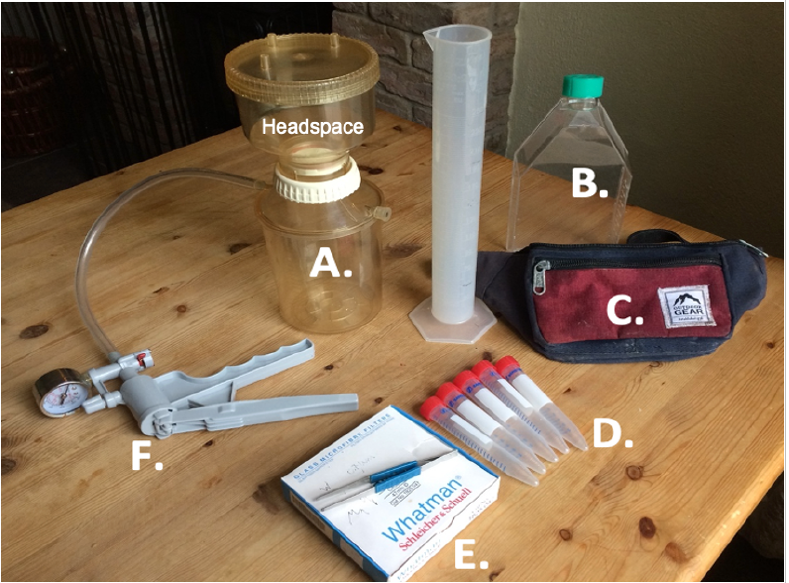
Figure 2. Kit used for preparation of Bovisand samples: filtration kit ( A ), sample bottle ( B ) carried into the surf using a bumbag ( C ), polycarbonate vials ( D ), Whatman 47 mm 0.7 µ m GF/F microfibre filters ( E ) and a hand pump ( F ) that was used to facilitate the filtering